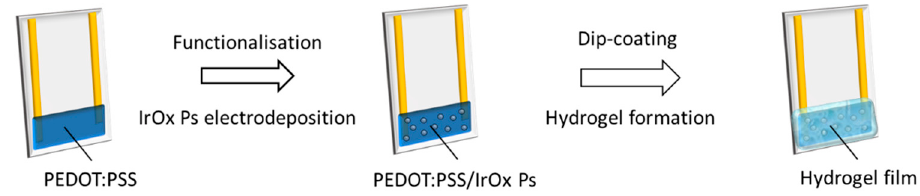
Figure 1. Schematic representation of the procedure employed for gas sensor